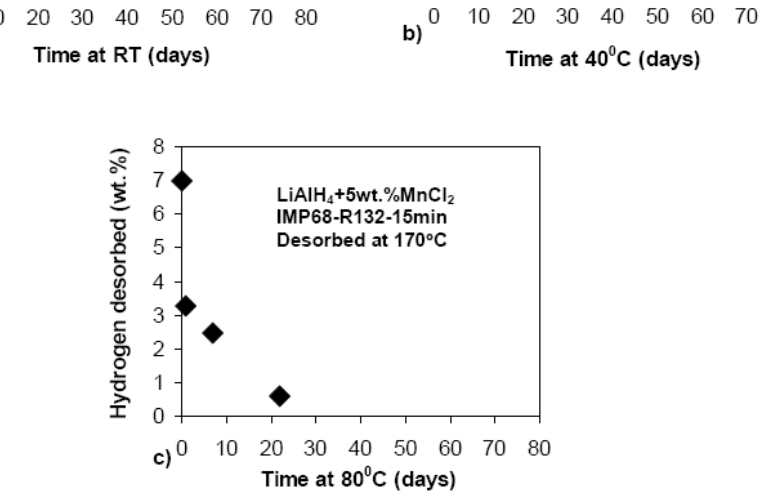
+ 5 wt.% MnCl . Adapted 4 2